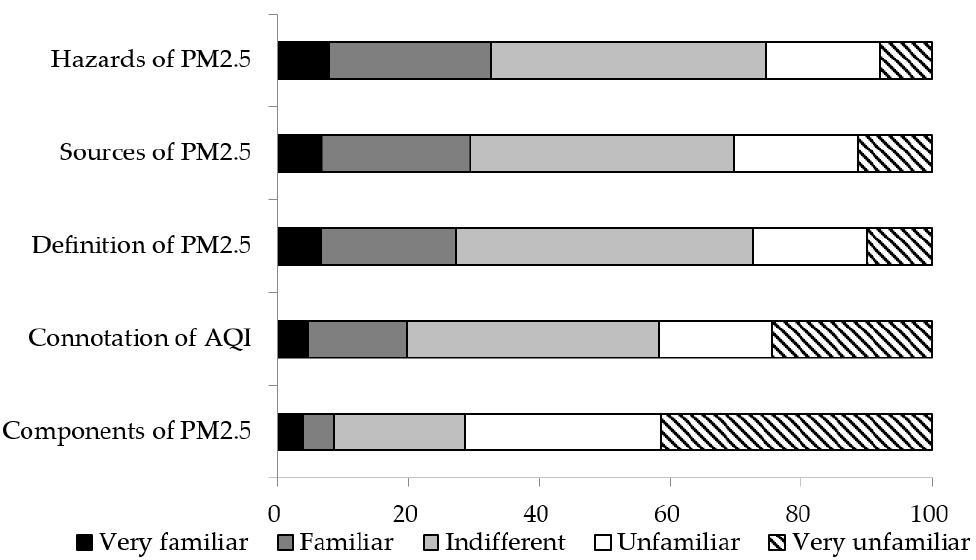
Figure 2. The distribution of self-reported the extent of knowledge about PM 2.5 .